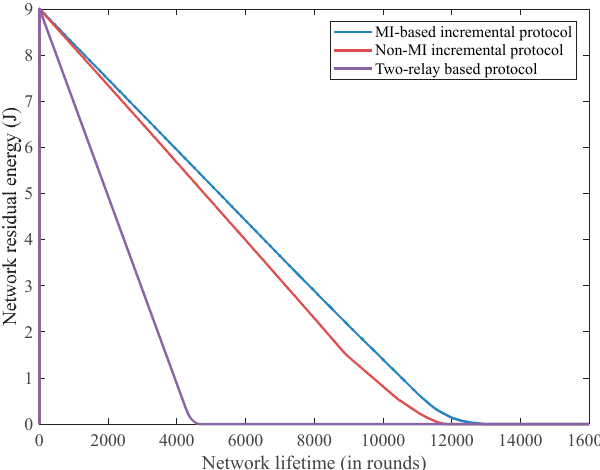
Figure 4. The number of dead implanted sensors versus network lifetime.